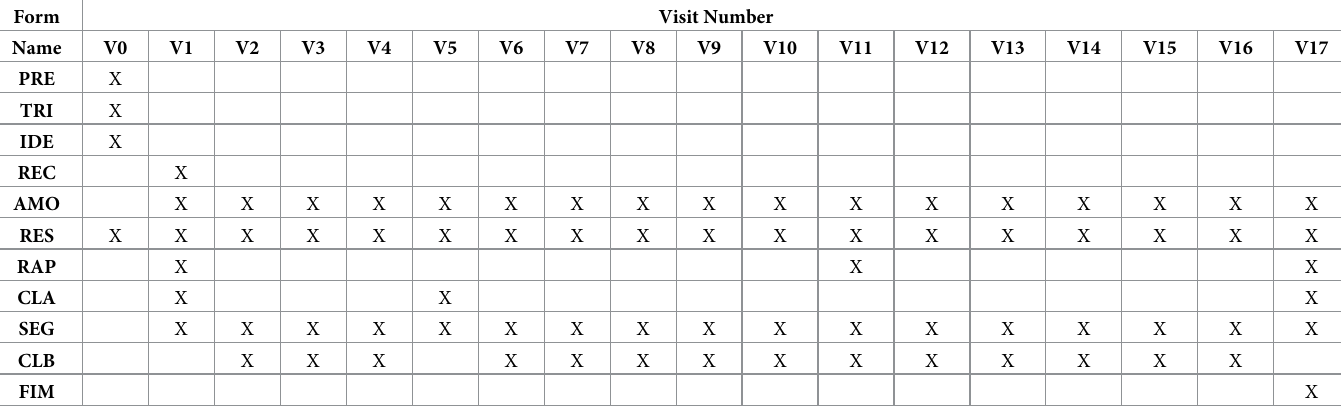
TRI (Screening): Symptoms of ZIKV